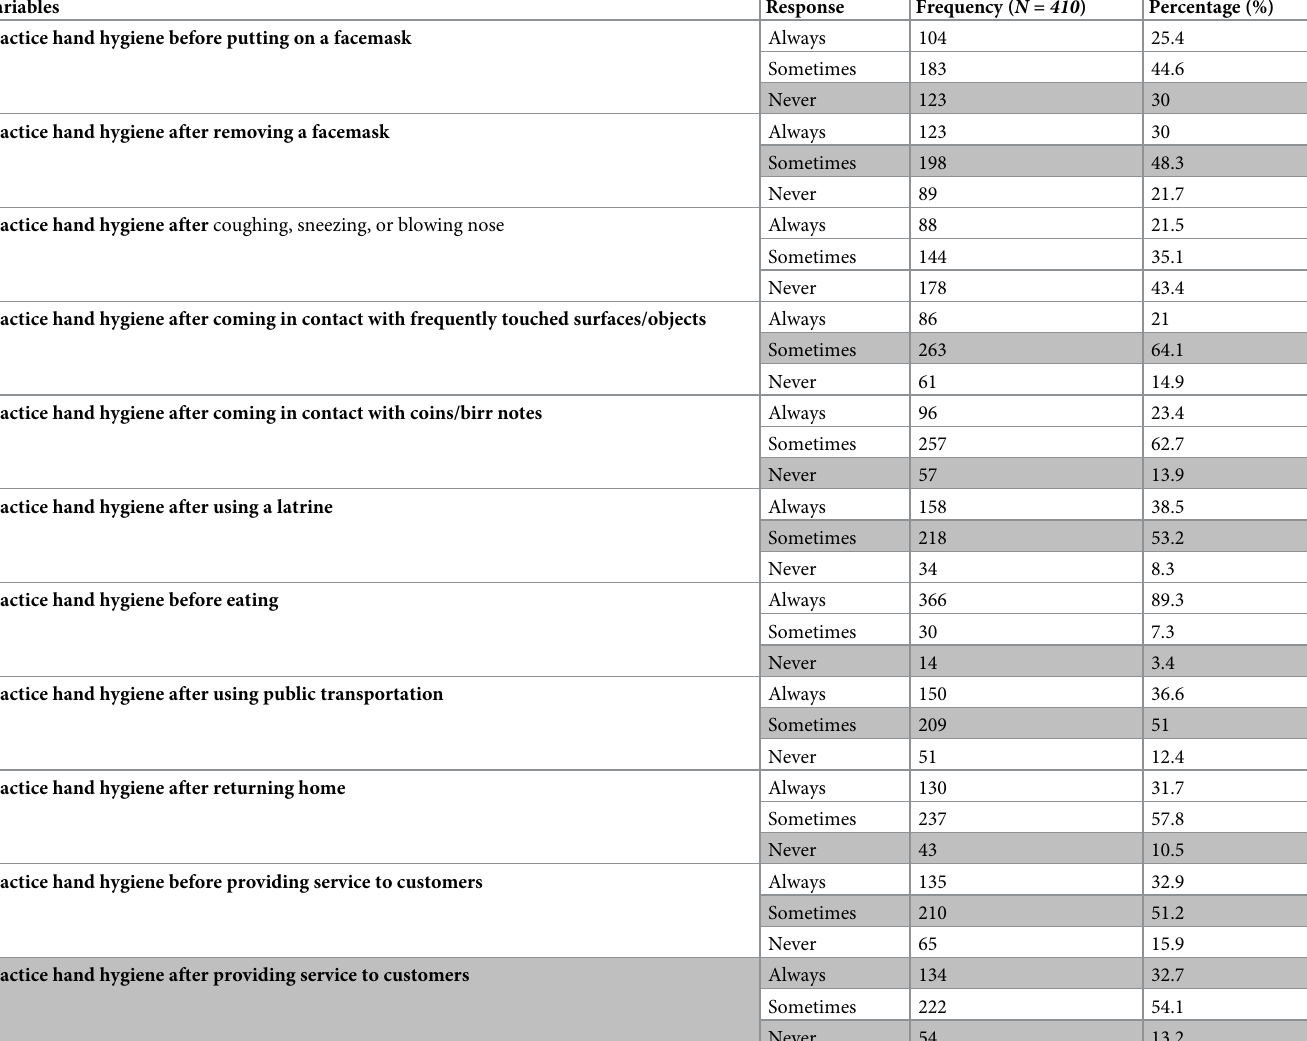
Table 3. Hand hygiene practices among barbers and beauty salon workers in Dessie City and Kombolcha Town, Northeastern Ethiopia, January 5 to February 10,